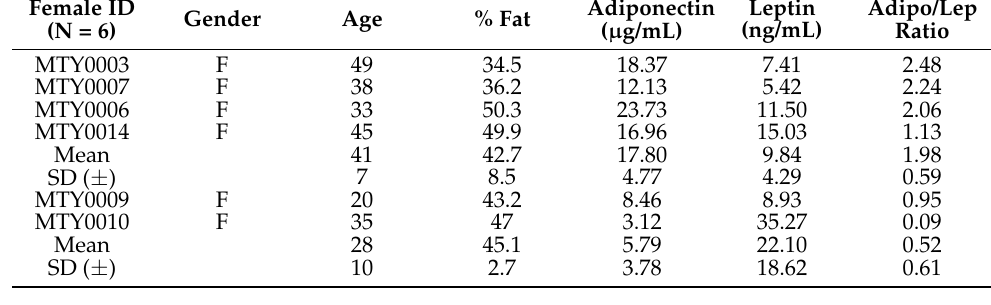
Table 5. Demographics and ALR measurements of each participant (N = 6).